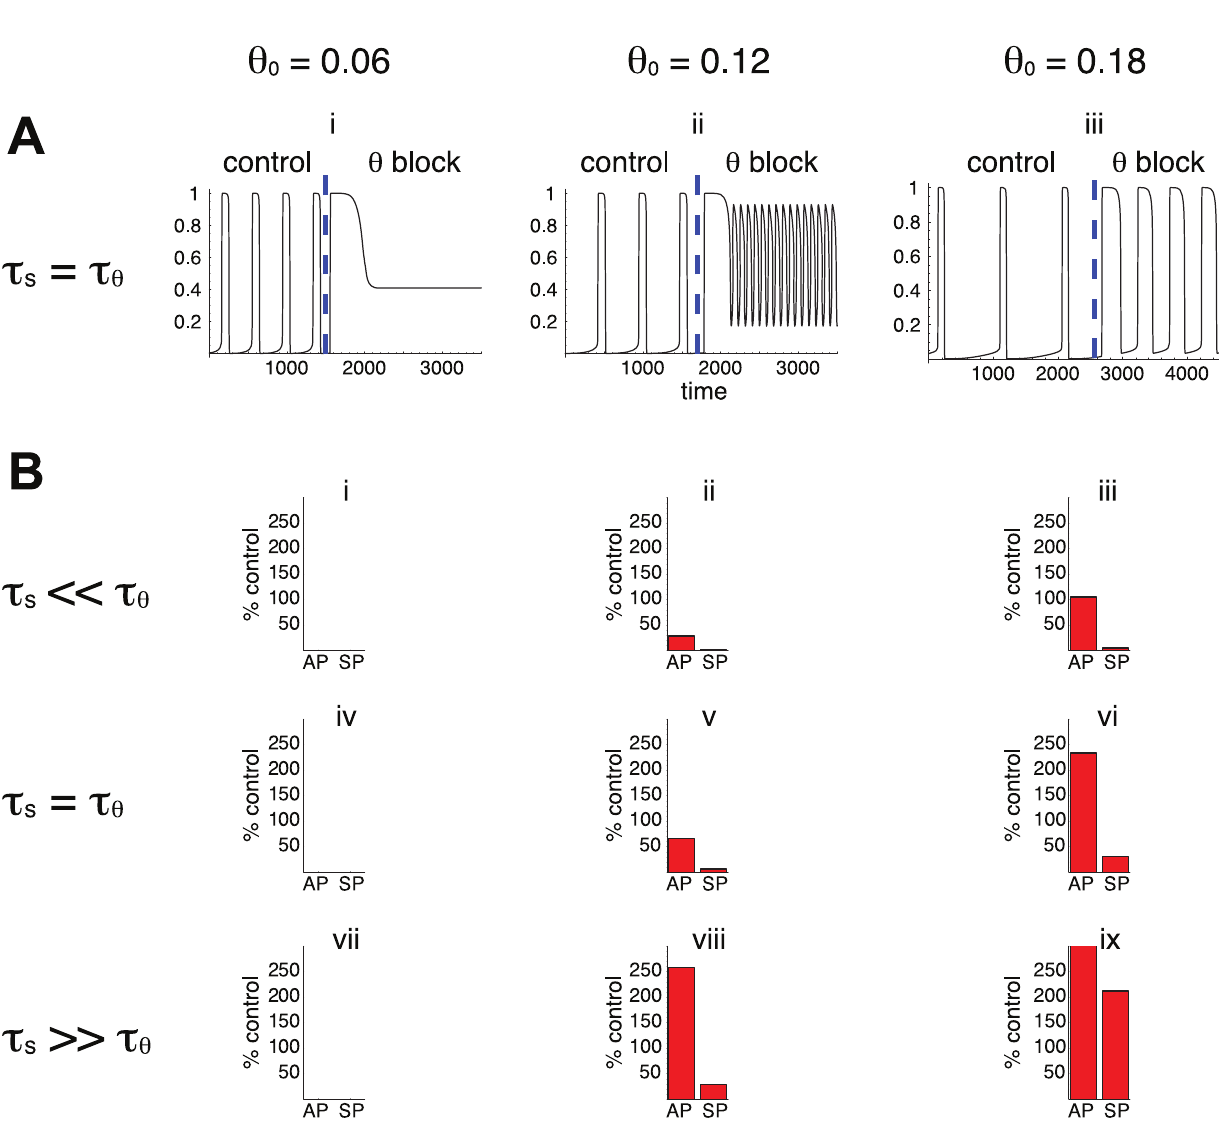
Figure 2. Illustration of the blockade approach. A. time course of network activity before (‘‘control,’’ g=1) and after (‘‘ h block,’’ g=0) blocking the adaptation process h . These simulations were obtained for t h / t s =1 and for the three values of h 0 indicated. Vertical dashed line indicates the time when the process was blocked. B. Effects of blocking h on the lengths of the active and silent phases (AP, SP), represented as percentage of ‘‘control’’. No bars are shown when rhythmic activity was abolished. There are more cases where h block results in decrease of SP duration (ii, iii, v, vi, viii) than increase in AP duration (vi, viii, ix). The interpretation is that h contributes more to delay episode onset than to provoke episode termination. The results of the blockade experiment depend on the value of h 0 , the activity threshold in the absence of adaptation, unlike the predictions from the correlative approach (Figure 1C). The blockade experiments also produces similar results in pairs of cases (iii, v) and (vi, viii) that have different t h / t s ratio; this is also in opposition to the correlative